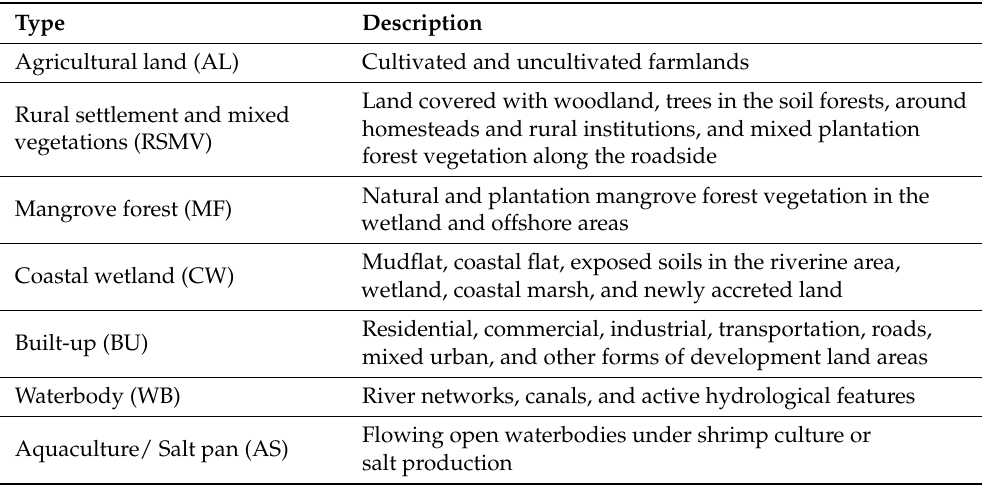
Table 1. Land use and land cover classification scheme for CRB .